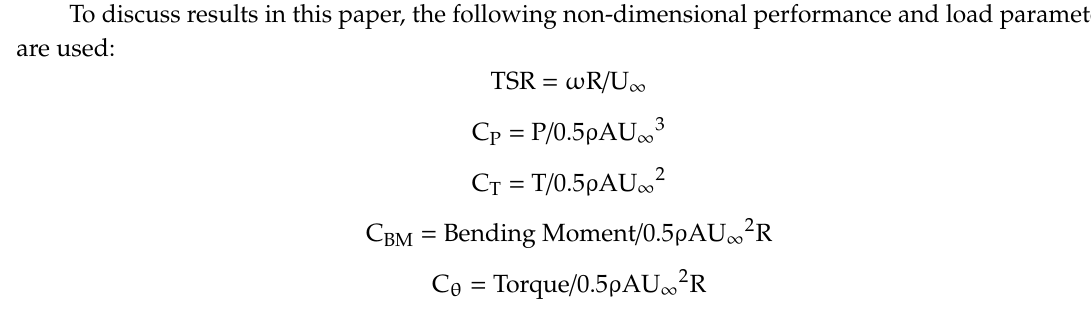
Figure 1. Velocity profile based on 1 / 7th power law (dashed lines represent turbine location).